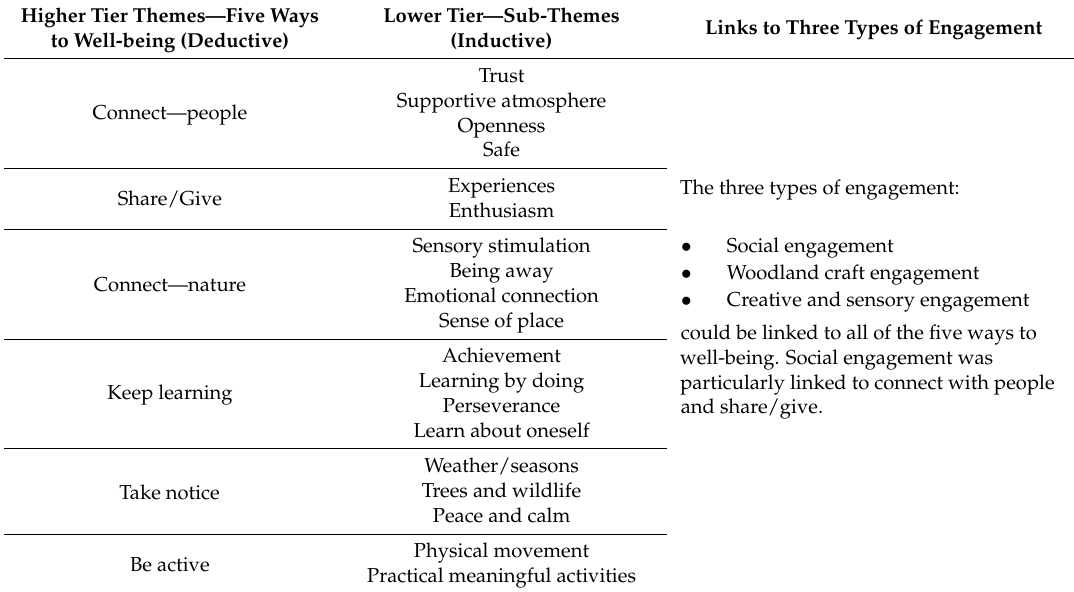
Table 5. The data coding structure using the five ways to well-being as a deductive framing and with sub-themes developed inductively. Lower Tier—Sub-Themes Links to Three Types of Engagement (Inductive) Trust Connect—people The three types of engagement: